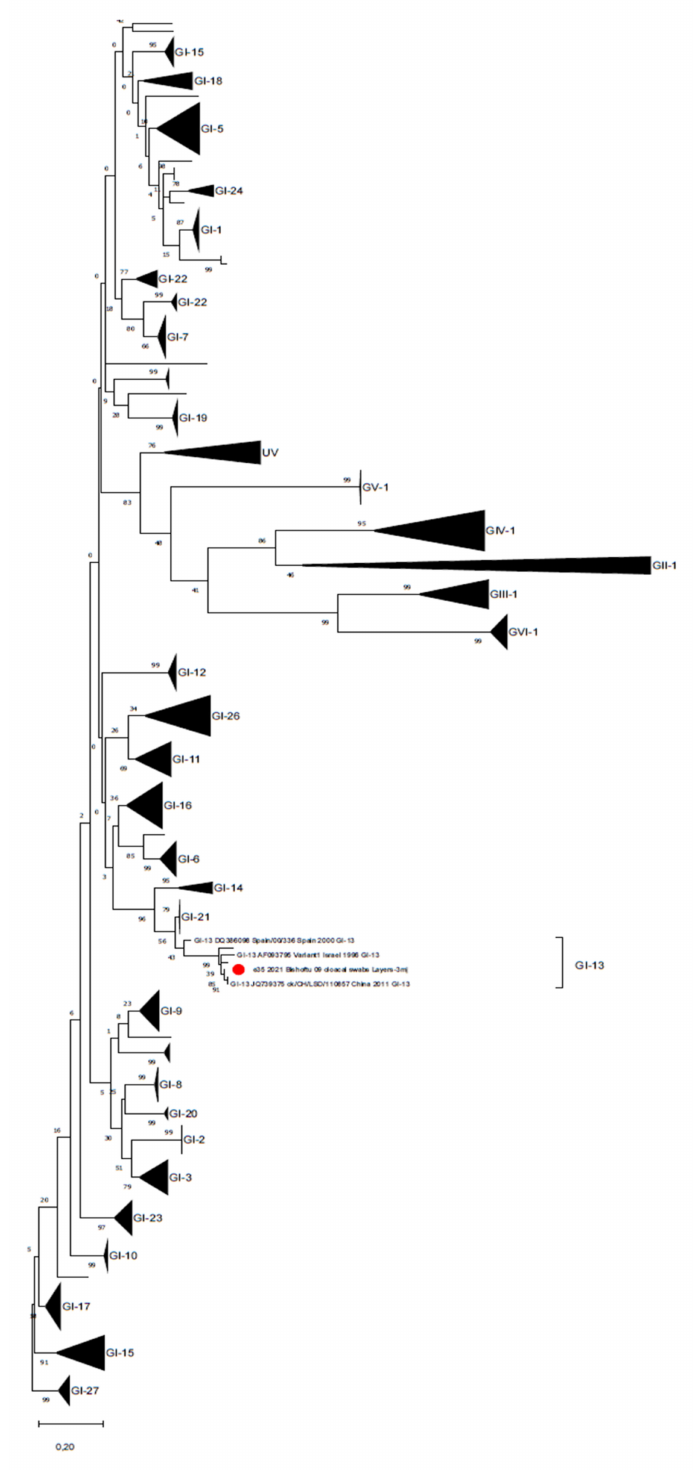
Figure 1. Phylogenetic tree reconstructed for IBV strain characterization with the database proposed by Valastro et al., (2016) [33]. The phylogenetic tree was reconstructed using the Maximum Likelihood method and General Time Reversible model with discrete Gamma distribution. Branch support is shown next to the branches. The Ethiopian strain is marked with a red circle, sequences belonging to the different lineages have been collapsed and single branches represent unique